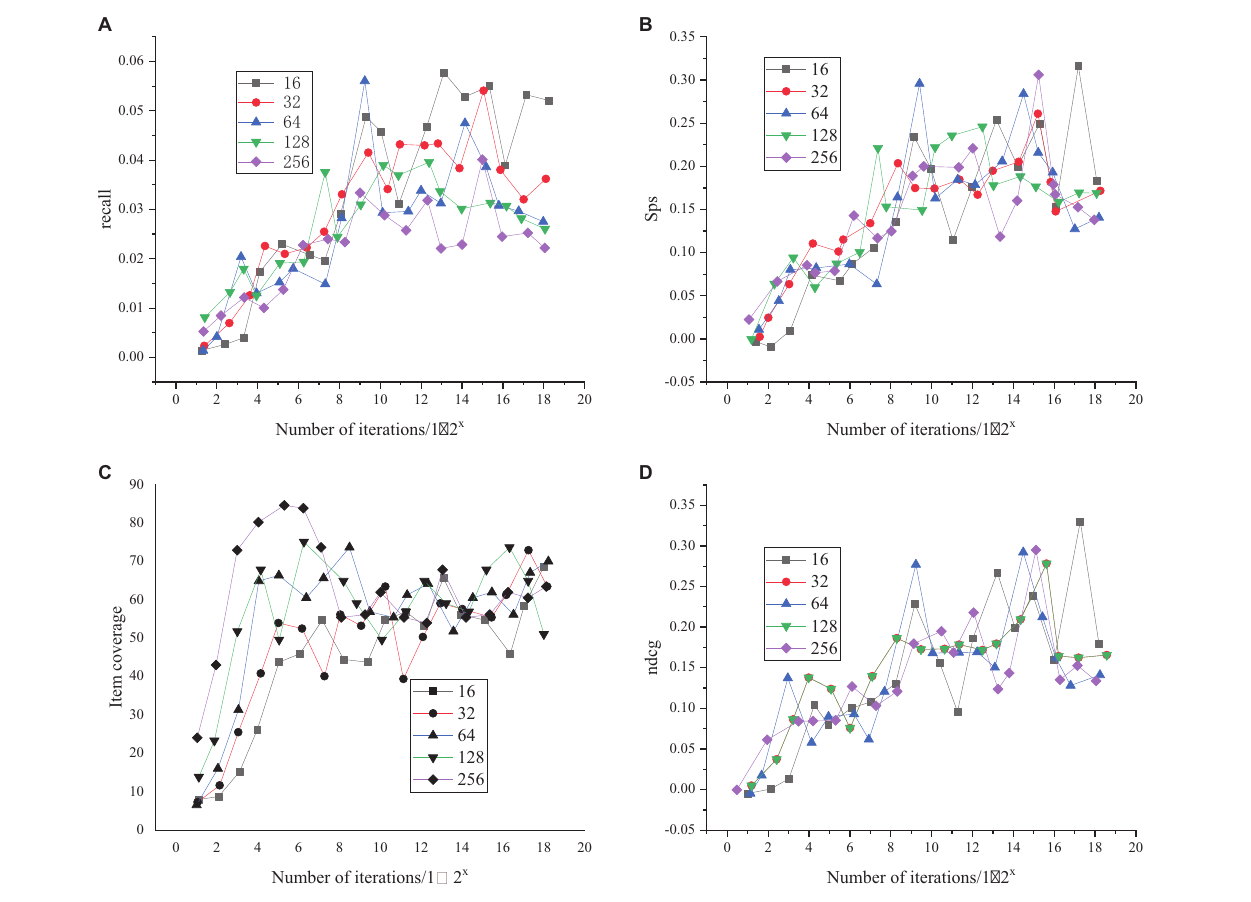
FIGURE 7 | Selection results of batch size parameters of the training model (A) represent the comparison results of recall rates under different batch sizes, (B) denotes the comparison results of SPS values under different batch sizes, (C) indicates the comparison results of item coverage under different batch sizes, and (D) is the comparison results of item recommendation quality under different batch sizes, represented by